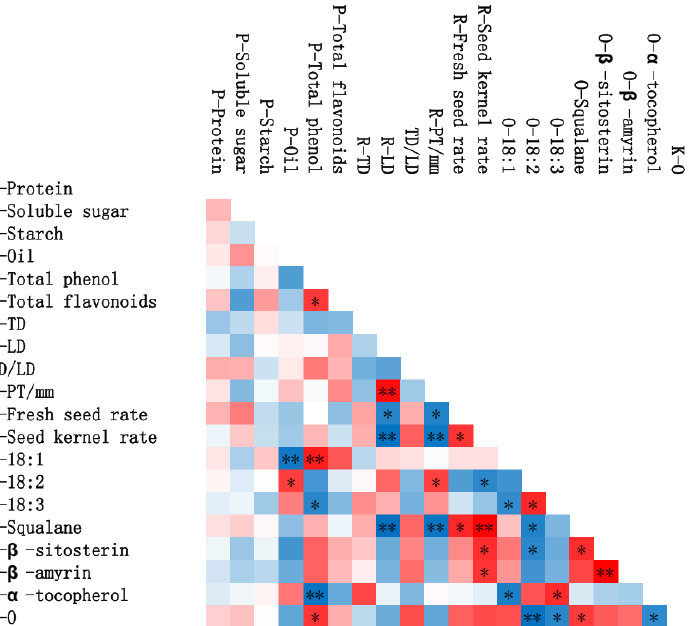
Figure 1. Red represents positive correlation, blue represents negative correlation, and the darker the color, the greater the correlation. * Significant at the 0.05 level (bilateral); ** significant at the 0.01 level (bilateral). P stands for peel, R stands for ROC , and K-O stands for oil content in kernels. Table 1. Phenotype, fresh seed rate and kernel rate of four ROC fruits .